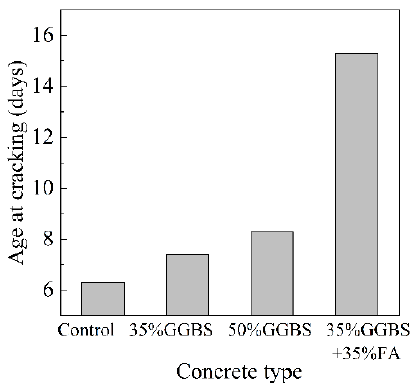
Figure 13. Ages at cracking of SCC, adding GBFS and FA [87].